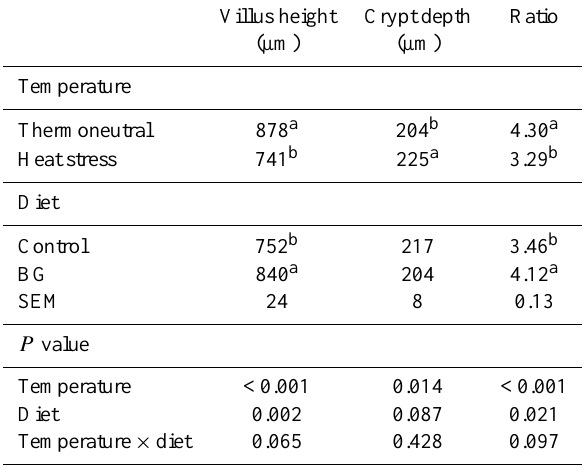
Table 4. Effect of propolis (bee glue; BG) on the morphology of the jejunum of broiler chickens subjected to heat challenge ( n =